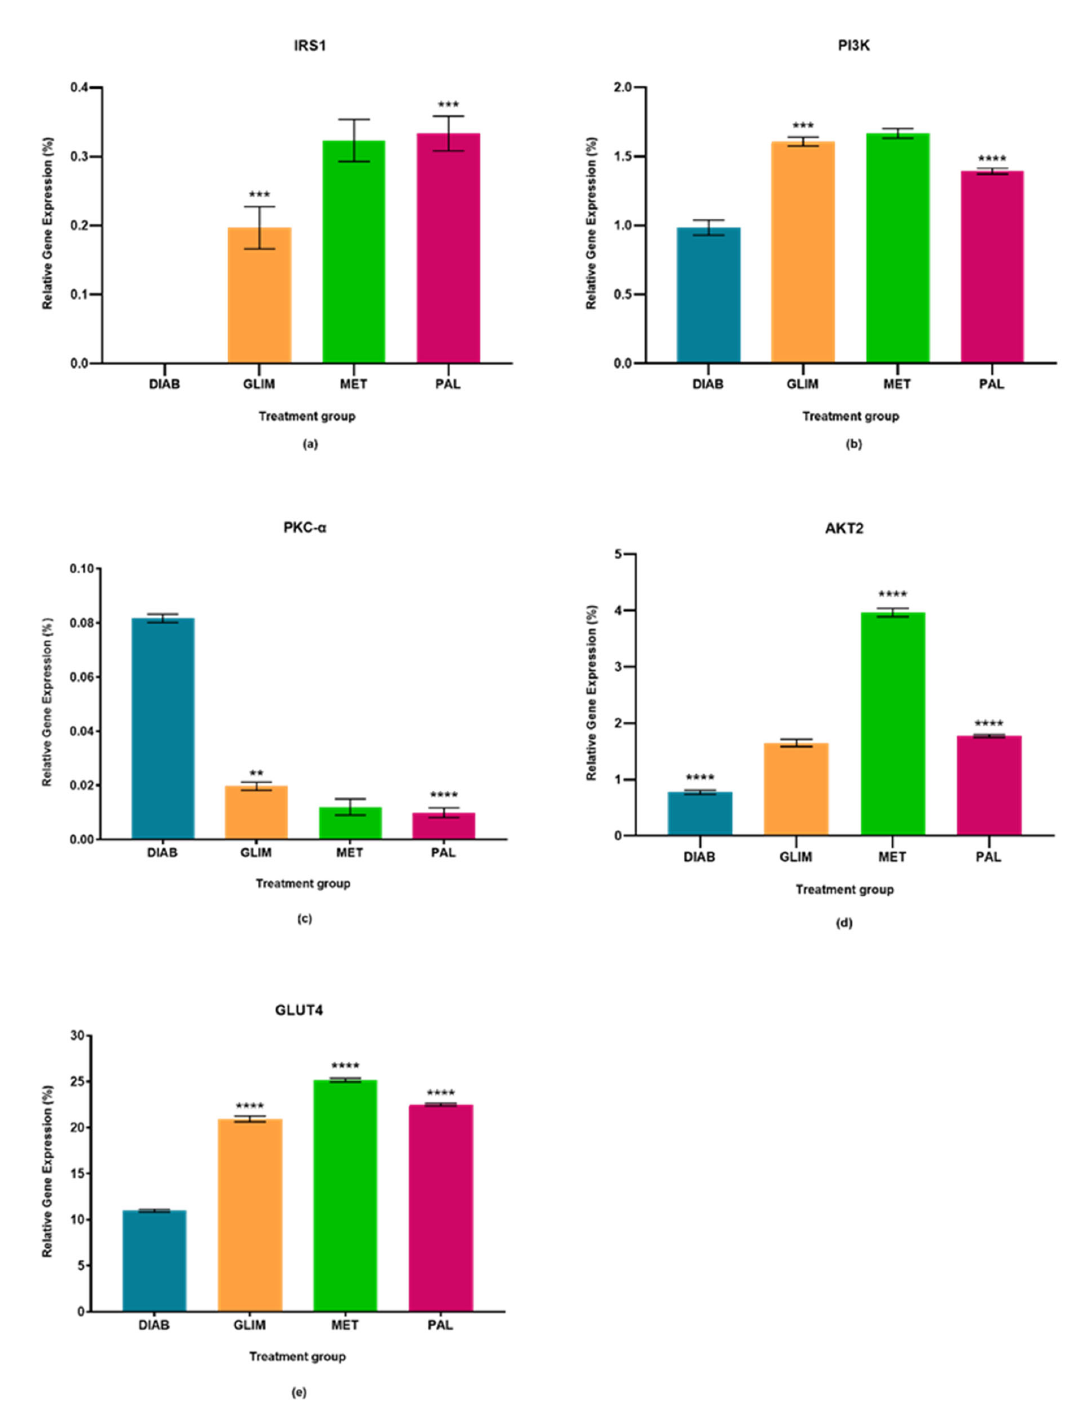
Figure 3. In the ex vivo model, relative quantification of ( a ) IRS-1, ( b ) PI3K, ( c ) PKC- α ( d ) AKT2, and ( e ) GLUT4 expressions in diabetic, glimepiride, metformin, and palmatine treatment groups. The gene was normalized against a geometric mean of two housekeeping genes ( β‐ actin and γ‐ actin). All the data points were presented as mean ± SD. Palmatine groups vs. other treatment groups: ** p < 0.01, *** p < 0.001, **** p < 0.0001.